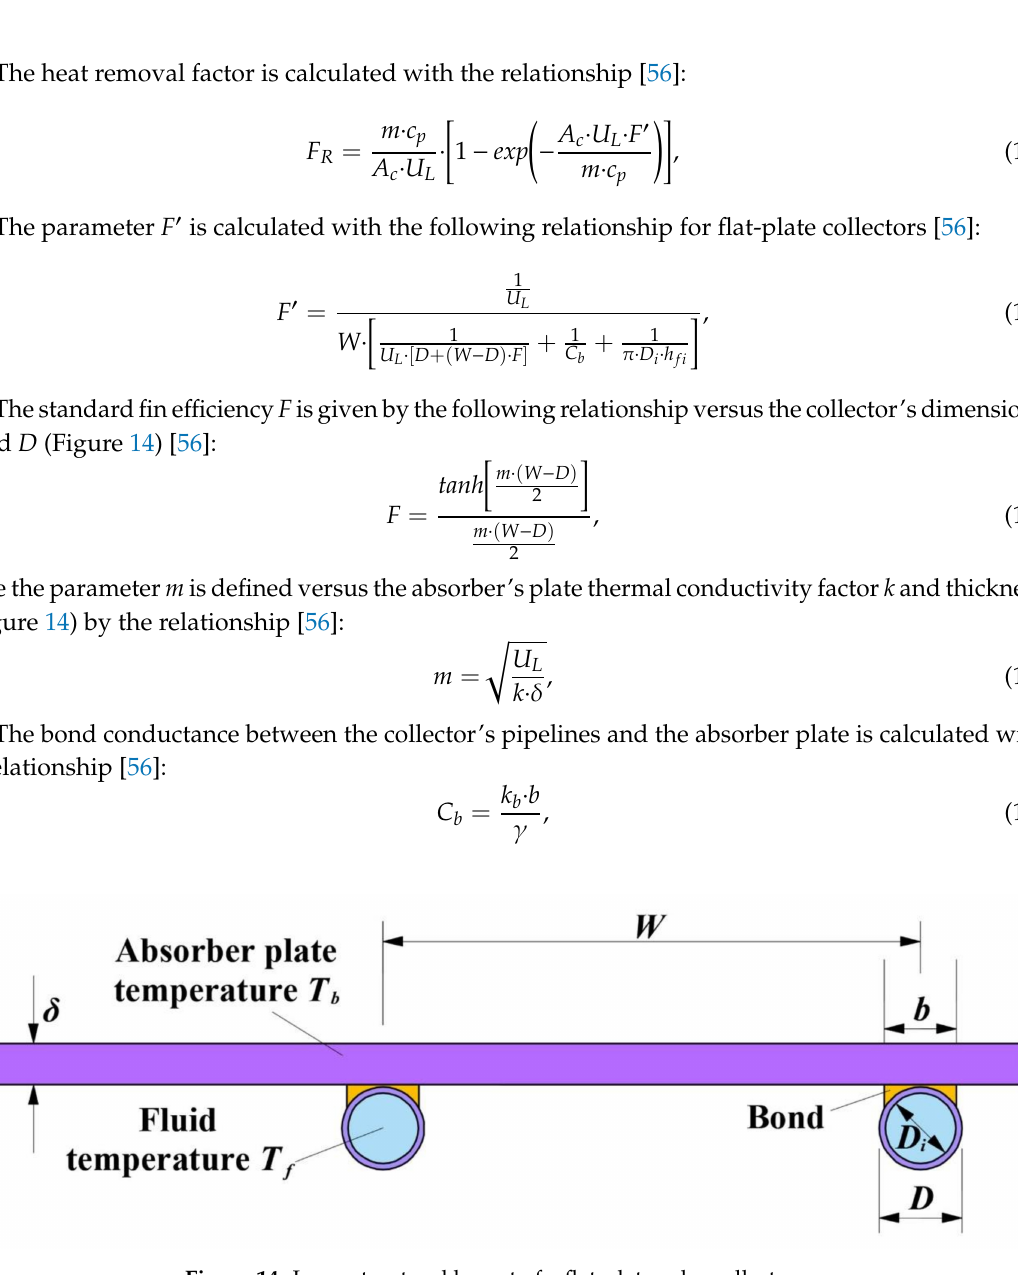
Figure 14. Inner structural layout of a flat-plate solar